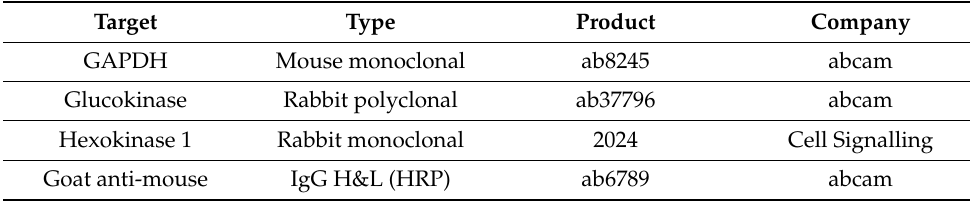
Table 1. Antibodies used in